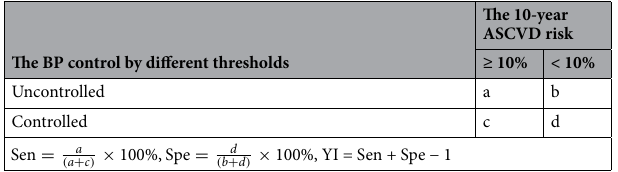
The 10-year ASCVD